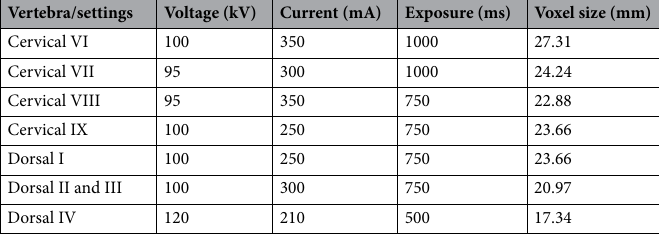
Table 5. Voltage, current and voxel size of each scanned element.